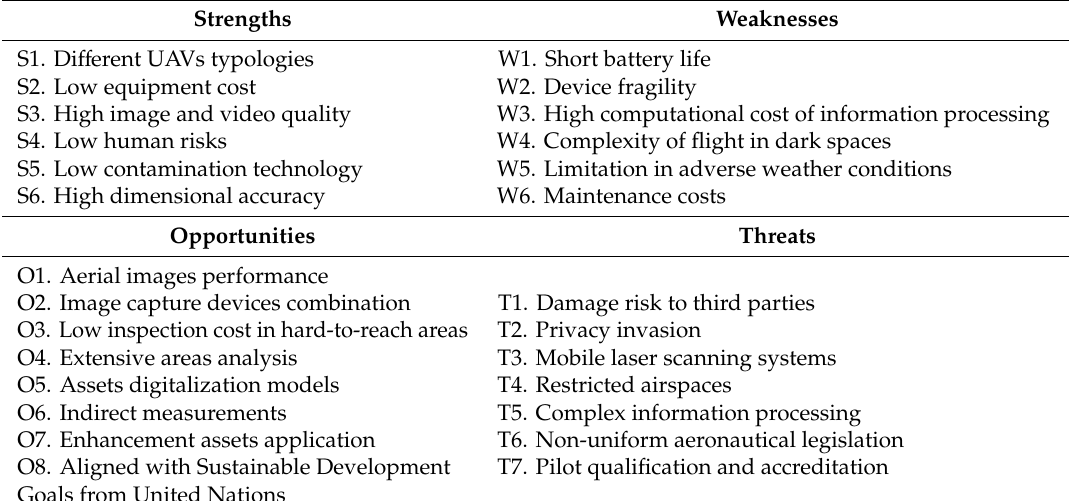
Table 1. SWOT Matrix for UAVs applications in heritage